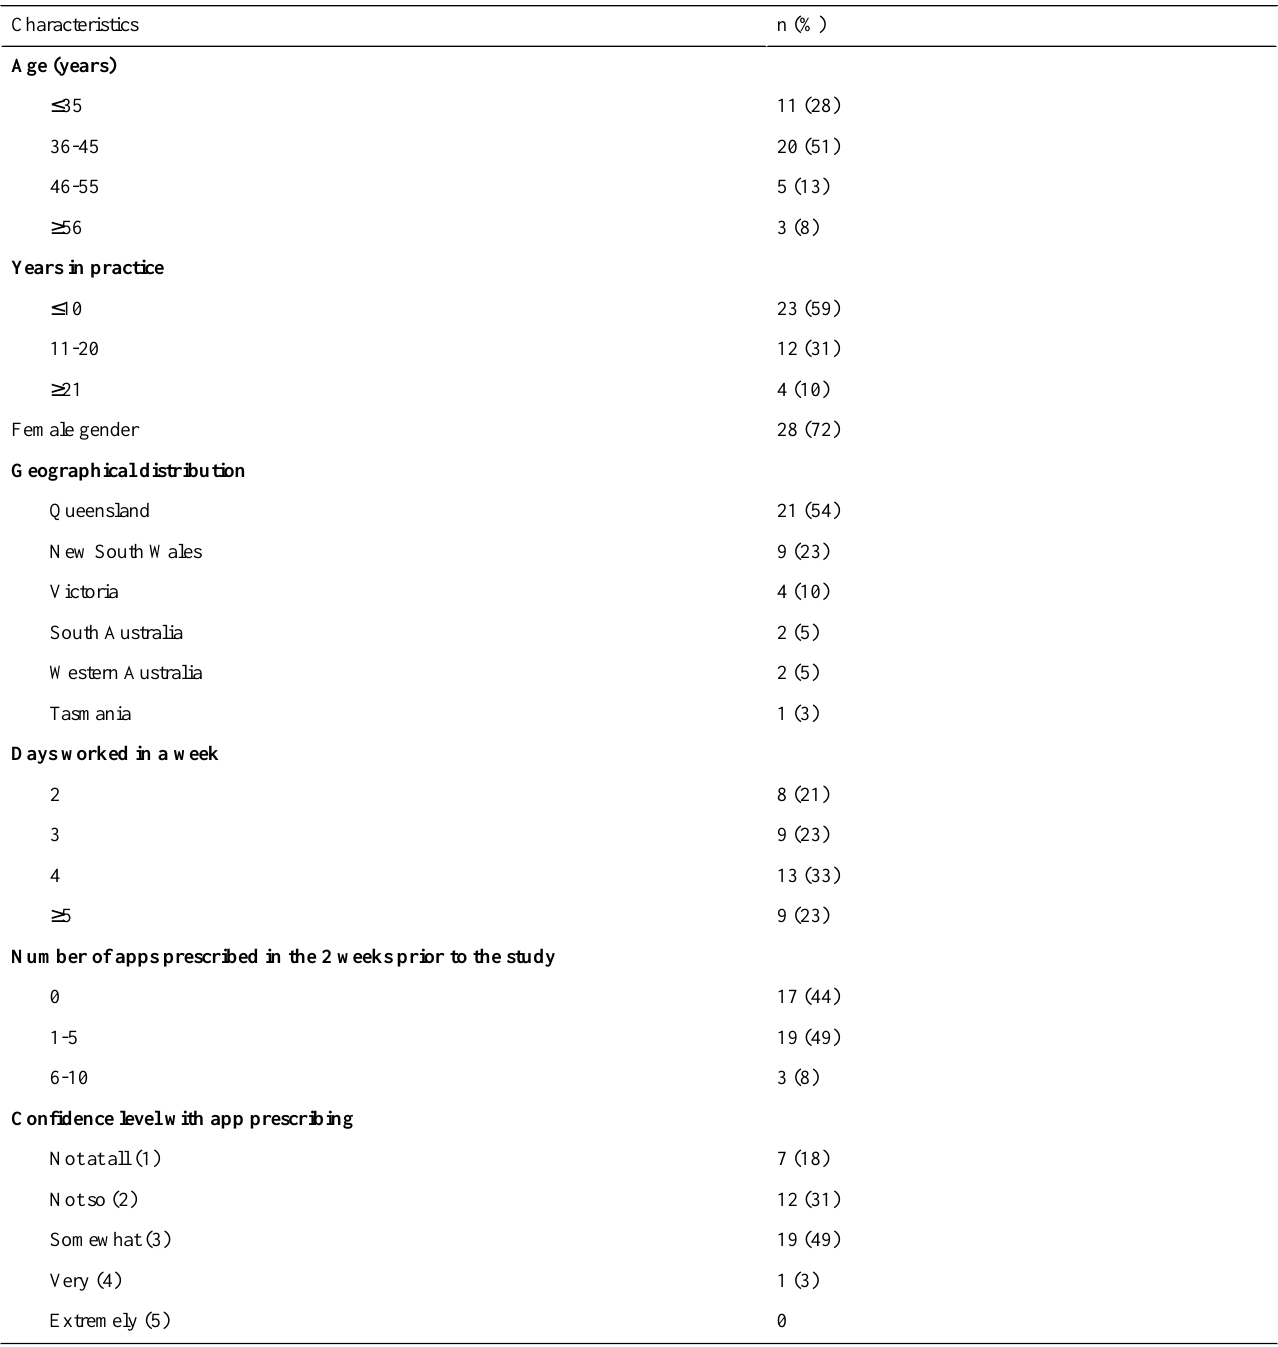
Table 1. Participant demographics and prestudy characteristics,